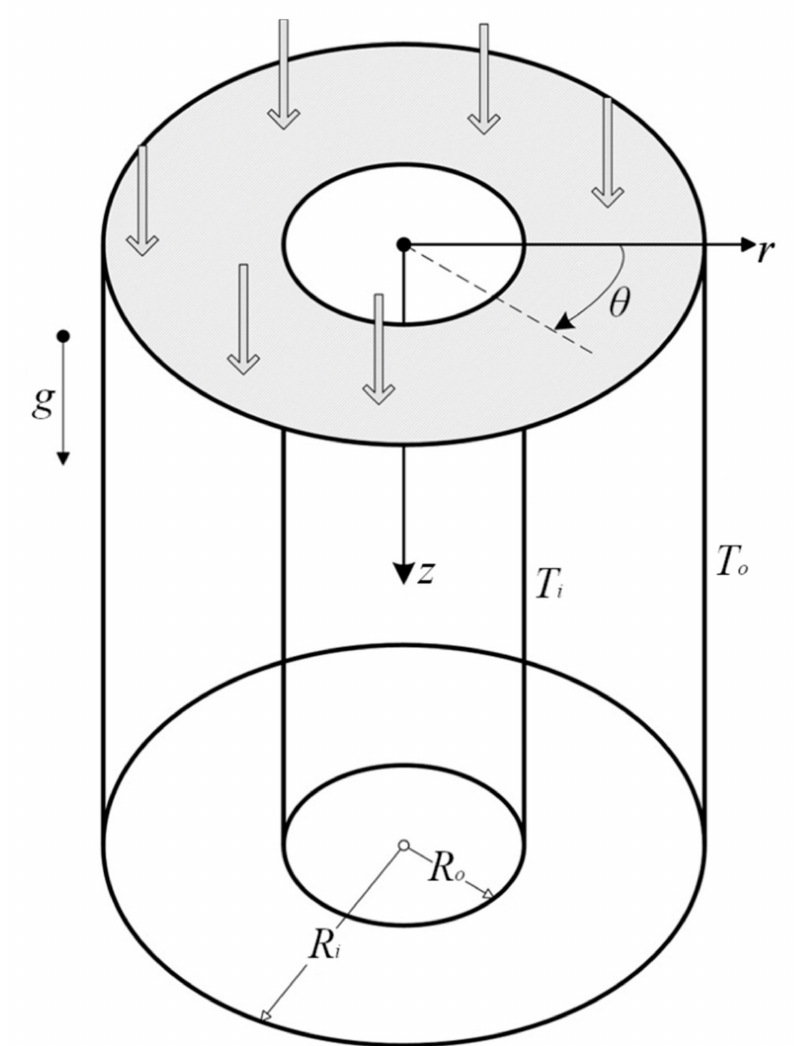
Figure 1. The coaxial system of the straight circular cylindrical annular